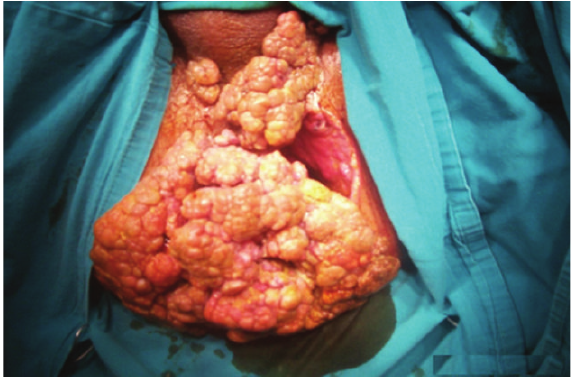
Figure 1: BLT covering all the perianal region.